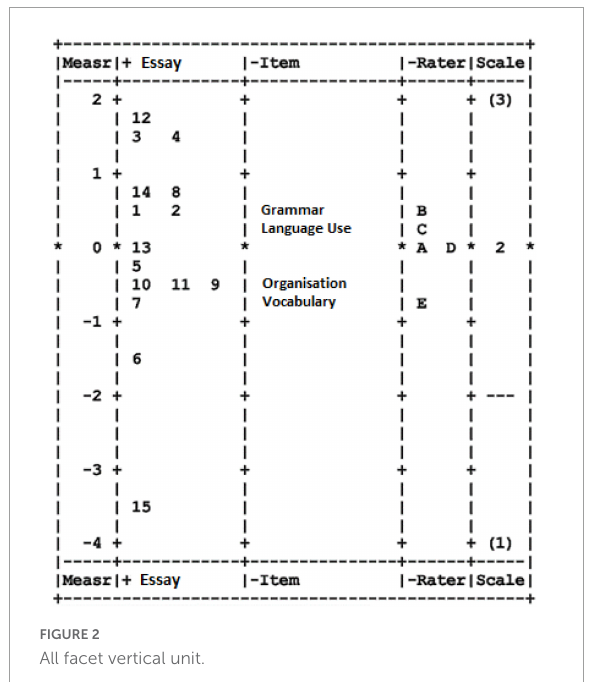
FIGURE2 All facet vertical